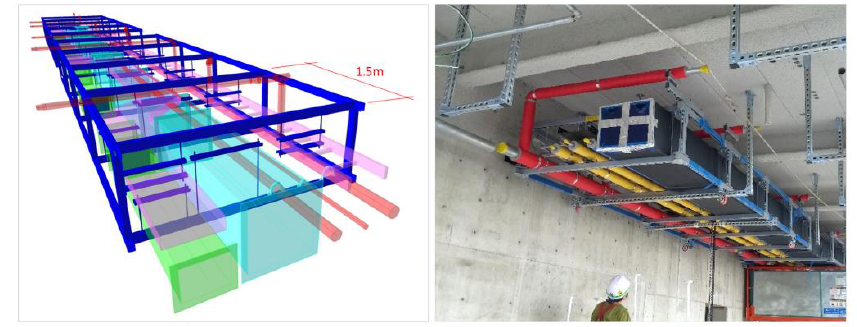
Figure 1. Type A: Frames in the form of a continuous set of cubes (supporting interval: 1.25 m).